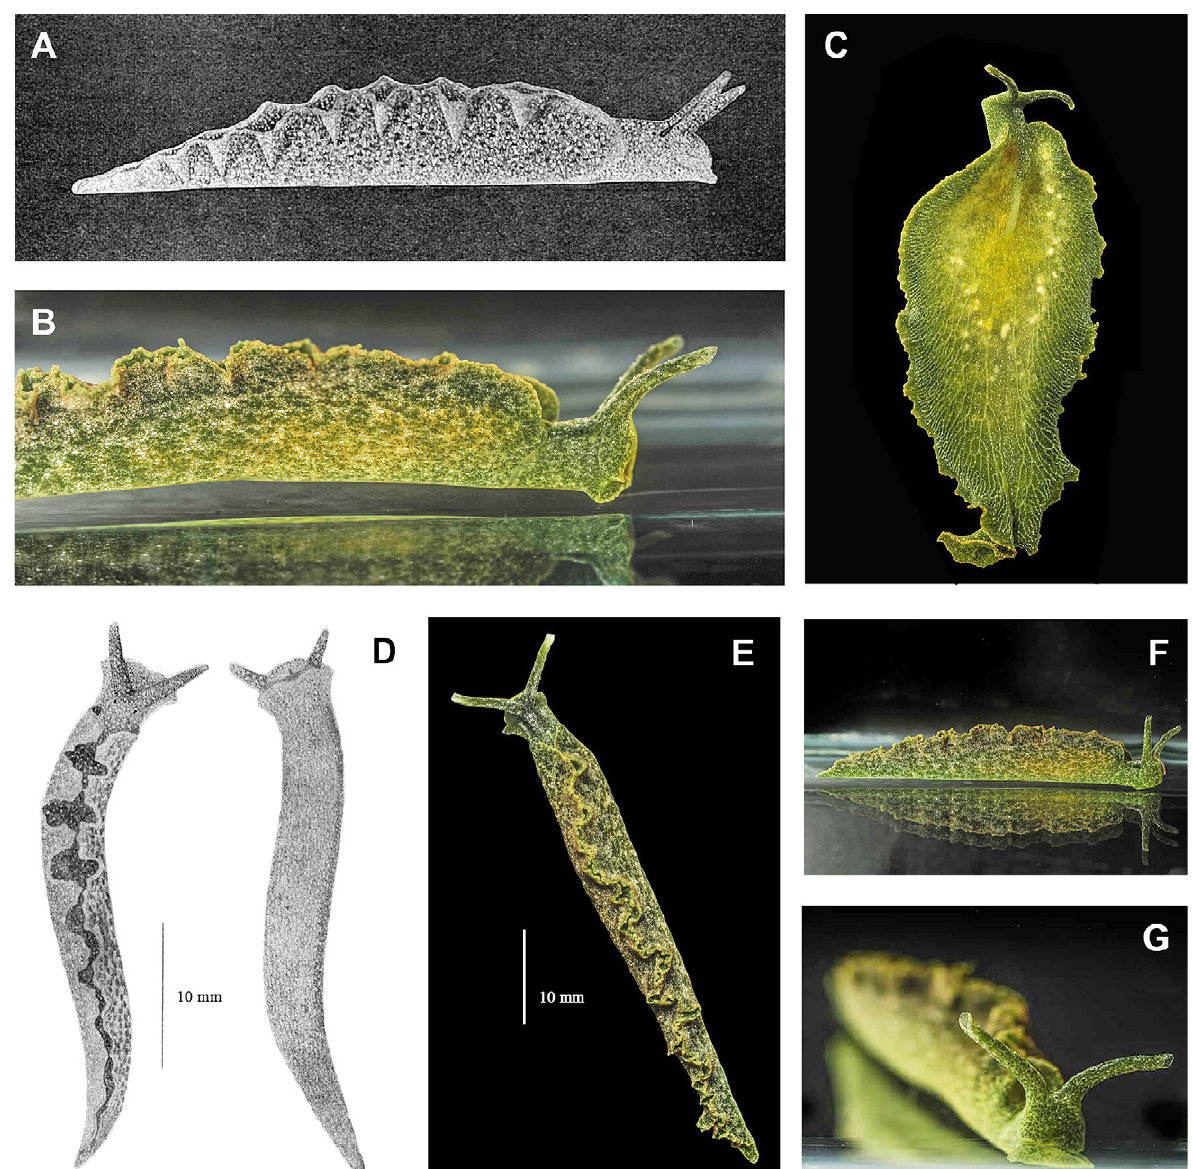
Figure 2. Elysia nealae. A. Original drawing (reproduced from Ostergaard 1955: pl. 1). B. Living Sardinian specimen. C. Dorsal view of a Sardinian specimen. D. Original drawing (reproduced from Ostergaard 1955: fig. 11) showing dorsal and ventral view. E. Living Sardinian specimen in dorsal view. F. Living Sardinian specimen in lateral view. G. Living Sardinian specimen in frontal view with rhinophores touching at the